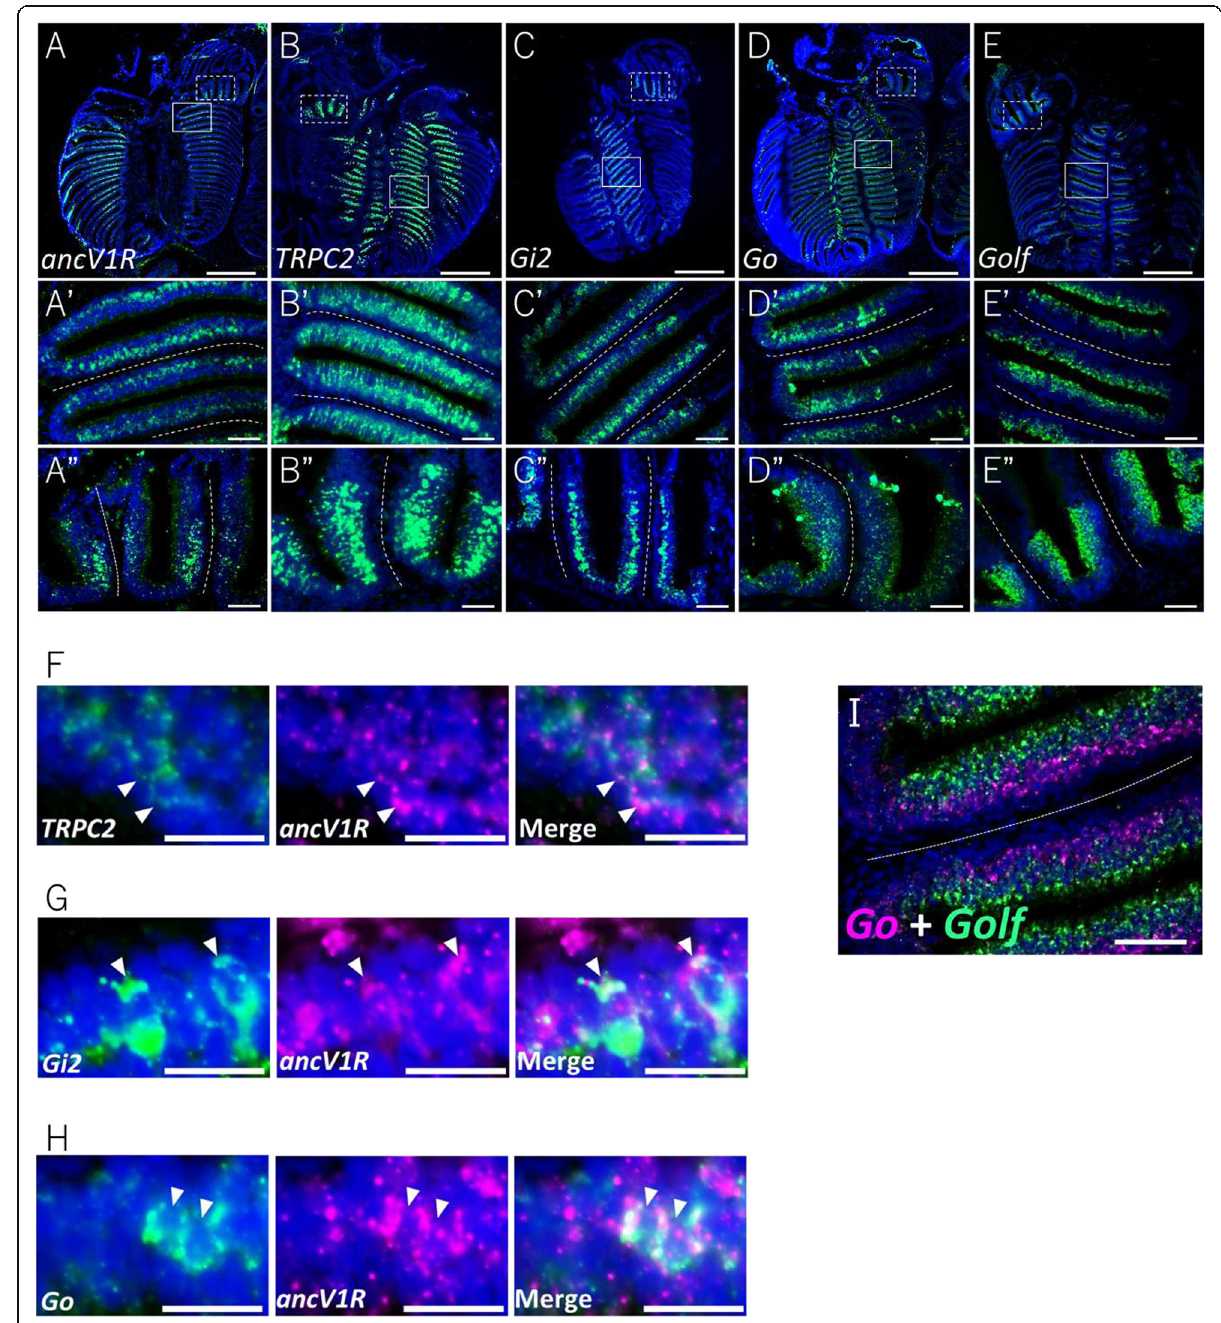
Fig. 4 Overall views of gene expression patterns in the olfactory organ of bichir. ( A - E ) The expression patterns of four VNO-related genes ( ancV1R , TRPC2 , Gi 2 , Go ) and MOE-related genes ( Golf ) in the olfactory lamellae. (A ’ -E ’ ) Higher magnification views of the MOO in the solid squares in ( A - E ). (A ” -E ” ) Higher magnification views of the lamellae of the AOO in the dotted squares in ( A - E ). Note that ancV1R , TRPC2 , Gi 2 , and Go are expressed in the basal layer, while Golf is expressed in the apical layer of the lamellae. ( F - H ) Coexpression of ancV1R (magenta) with ( F ) TRPC2 , ( G ) Gi2 , and ( H ) Go (green). Arrowheads indicate the coexpressing cells. ( I ) Contrasting expression patterns of Go (magenta) in the basal layer and Golf (green) in the apical layer of the MOO lamellae confirmed by two-color FISH. The cell nuclei were stained by DAPI (blue). The dotted line indicates the center of the lamellae. The scale bars indicate 500 μ m ( A - E ), 50 μ m (A ’ -E ’ , A ” -E ” , I), or 20 μ m ( F - H